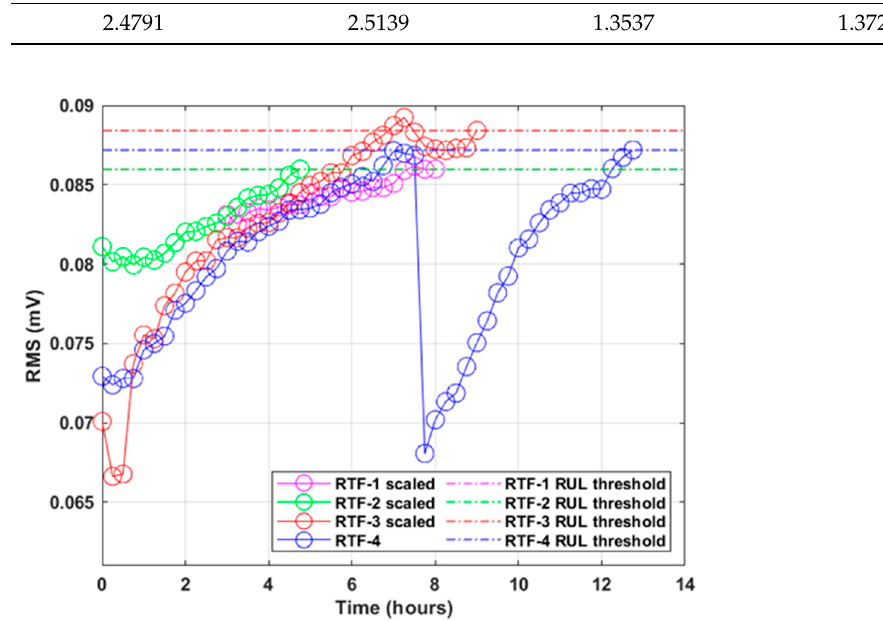
Figure 14. RMS data from all RTF tests scaled by location and speed factors.